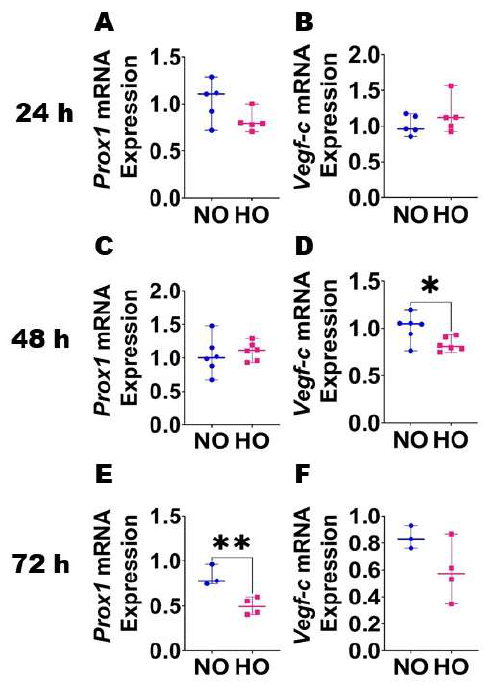
Figure 1. Effects of HO exposure on the expression of lymphangiogenic molecules in HDLECs . RNA was extracted at the indicated time points from cells grown on six-well plates to 60–70% confluence and exposed to NO (21% O 2 and 5% CO 2 ) or HO (70% O 2 and 5% CO 2 ) for up to 72 h. The RNA was later transcribed to cDNA and subjected to real-time RT-PCR analysis to quantify the mRNA levels of Prox1 ( A , C , E ) and Vegf-c ( B , D , F ) at 24 h ( A , B ), 48 h ( C , D ), and 72 h ( E , F ). Values represent the median with range ( n = 3–6/group). Significant differences between exposures are indicated by *, p < 0.05, **, p < 0.01 ( t -test).